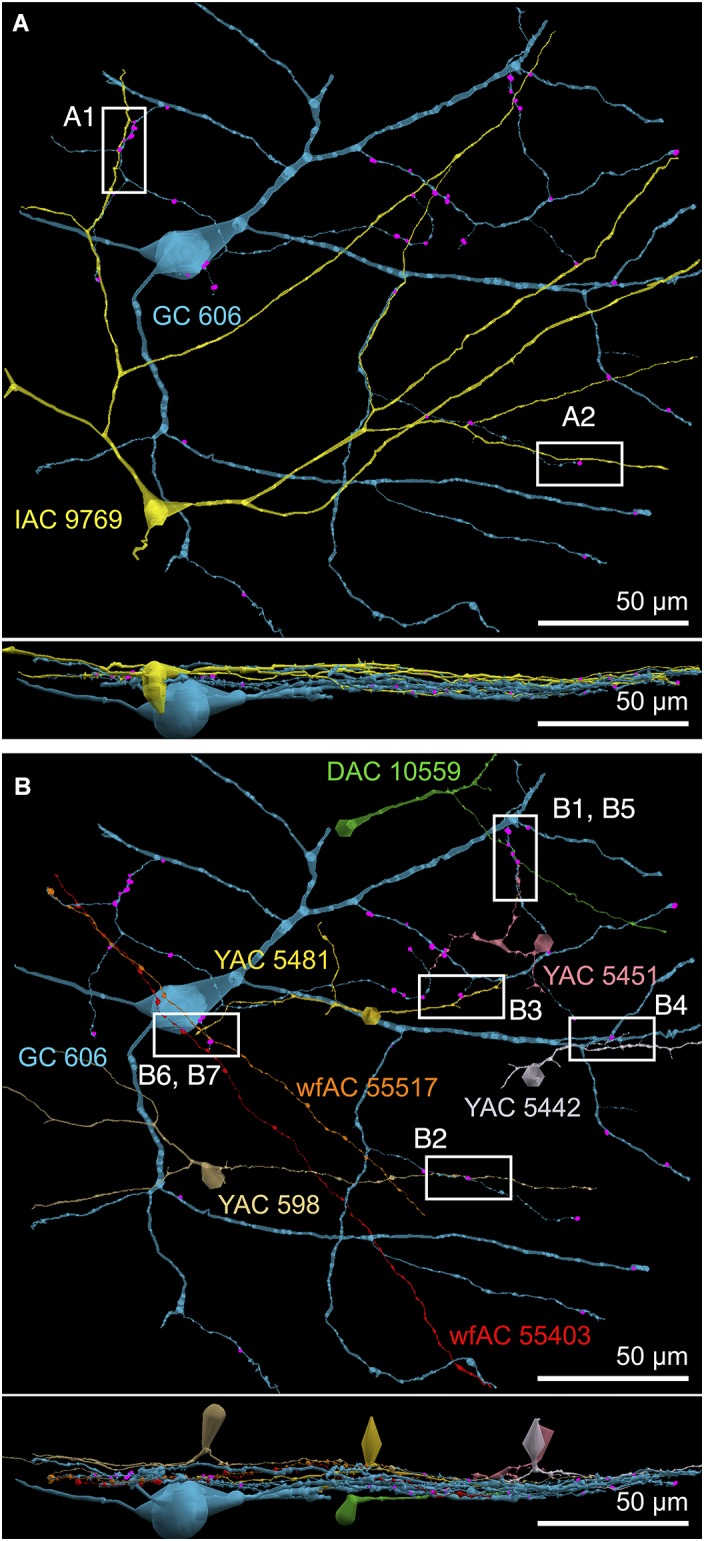
Selected sites of heterocellular coupling between inhibitory amacrine cells and GC 606. (A) Two loci of coupling (A1, A2) between IAC 9769 and GC 606 viewed as a horizontal field. Lower image, vertical overlay. (B) Seven loci of coupling between displaced amacrine cell (DAC) 10559; γ+ amacrine cells with somas in the RC1 volume (YACs) 5481, 5442, 5481, and 598; and wide-field γ+ amacrine cell (wfAC) processes 55403 and 55517 arising from somas outside the volume. Horizontal and vertical overlays. High resolution analyses of these loci are shown in Figure 10.